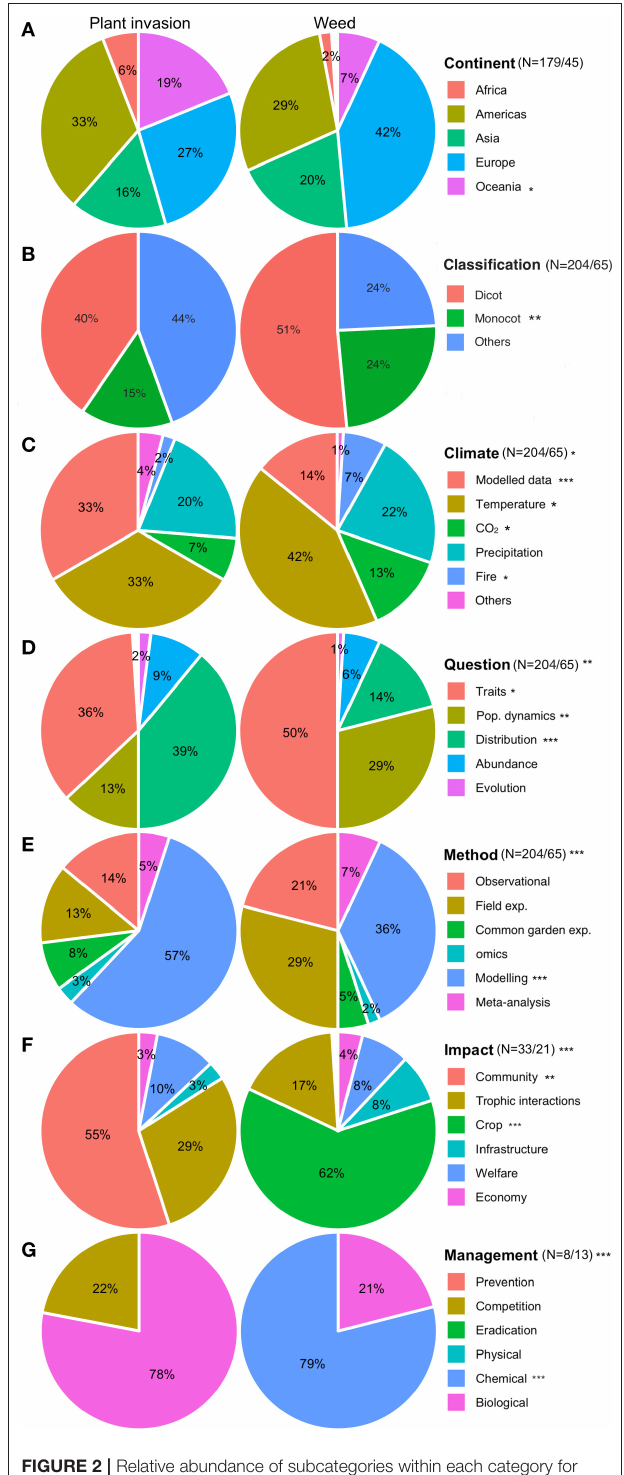
FIGURE 2 | Relative abundance of subcategories within each category for both plant invasion and weed science, and number of studies and comparisons between the disciplines, with *** p ≤ 0.001, ** p ≤ 0.01, * p ≤ 0.05, empty: p > 0.05. (A) Continent of the first author, (B) study plant classification, (C) climate feature studied, (D) research question, (E) main method used, (F) assessed impact, and (G) evaluated management